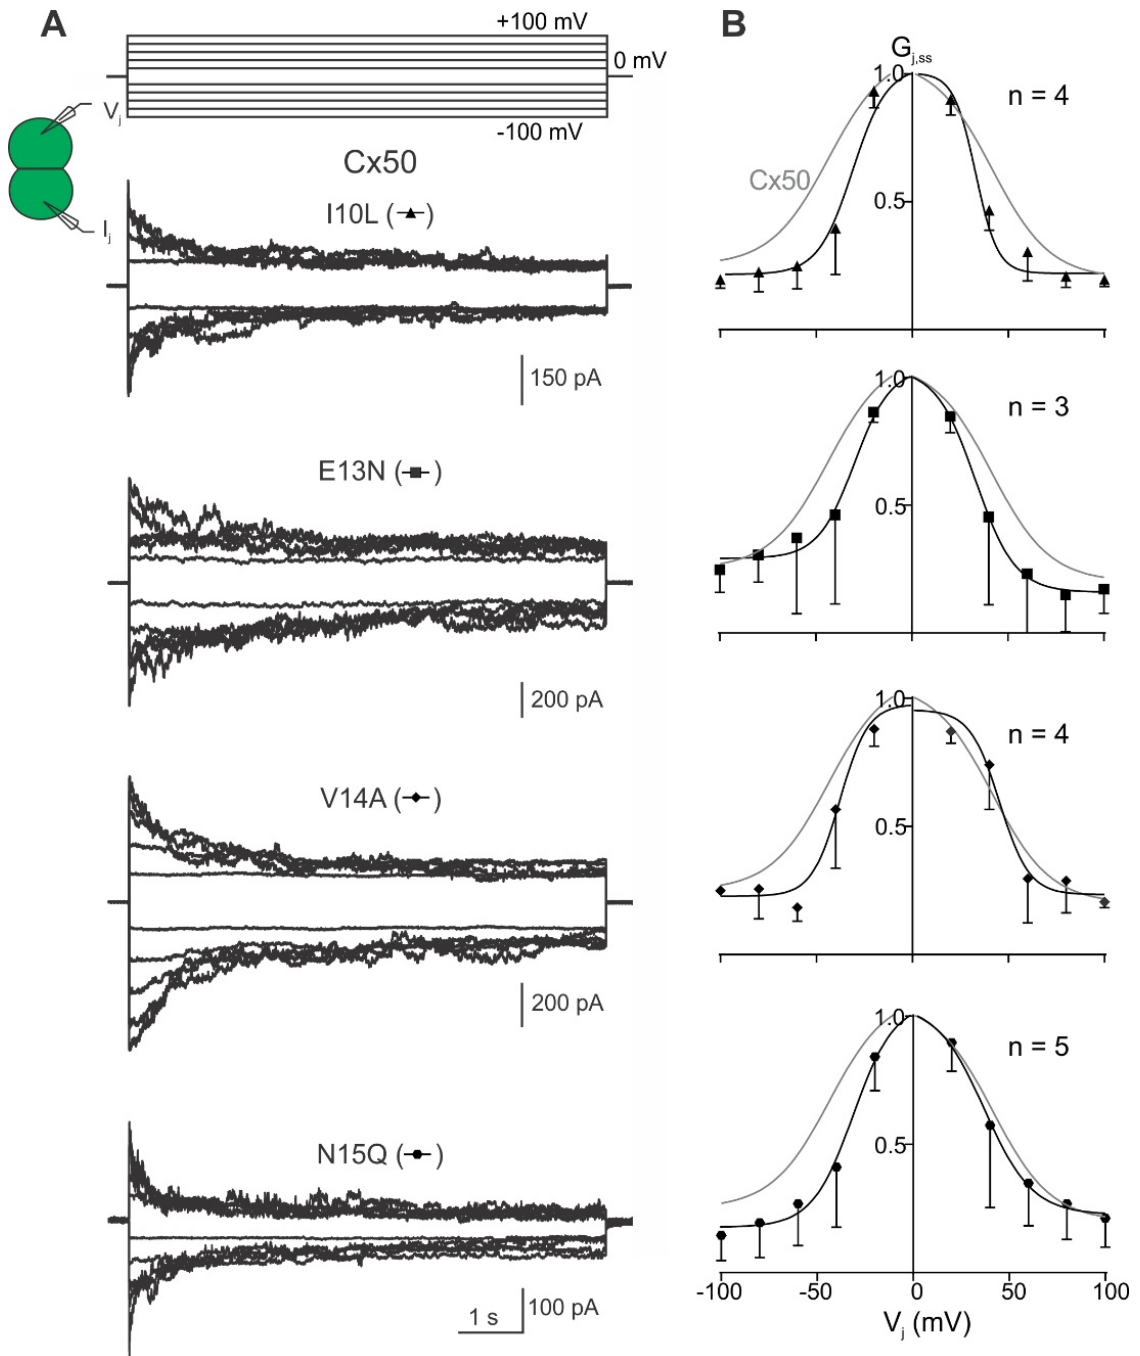
Figure 5. V j -gating properties of the GJs formed by Cx50 variants, I10L, E13N, V14A, or N15Q. ( A ) Superimposed junctional currents (I j s) from cell pairs expressing I10L, E13N, V14A, and N15Q are illustrated in response to a series of voltage pulses (V j s) ranging from ±20 to ±100 mV in 20 mV increments. ( B ) Normalized steady-state junctional conductance (G j,ss ) was plotted against a tested V j range for I10L (solid triangles), E13N (solid squares), V14A (solid diamonds), and N15Q (solid hexagons) GJs. The Boltzmann fitted curves (smooth solid black lines) for variants and for wild-type Cx50 (smooth solid grey lines) are superimposed for direct comparison. The number of cell pairs for each variant is indicated on the respective plot. Error bars represent SD. Table 1. Boltzmann fitting parameters for the GJs of Cx46 and its variants.